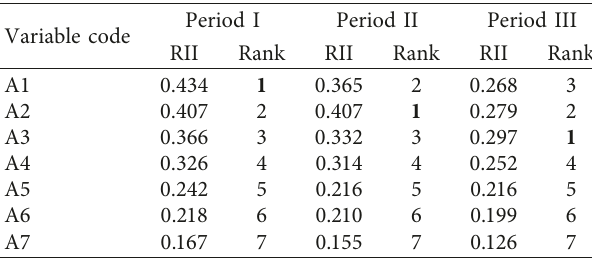
Table 13: Result of the risk importance index (RII) for material